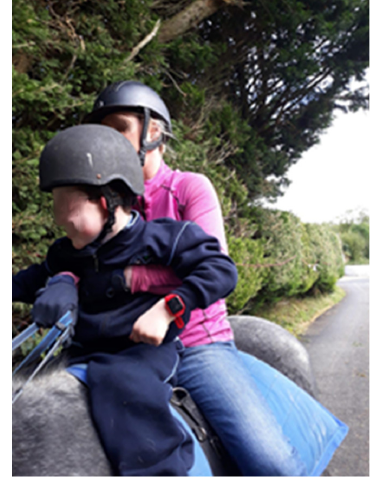
Figure 6. Ethan at his equine therapy session.